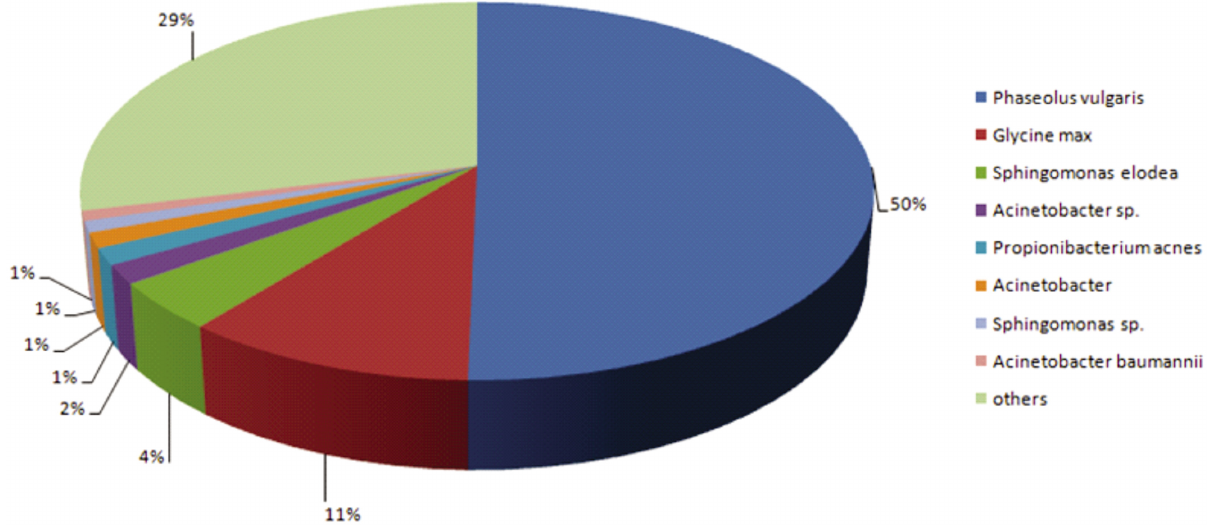
Fig 2. Blast hit distribution of black gram TCS showing similarity with known proteins in non-redundant (nr) database available at NCBI using BLASTx algorithm with an E value threshold of 10 – 5 .